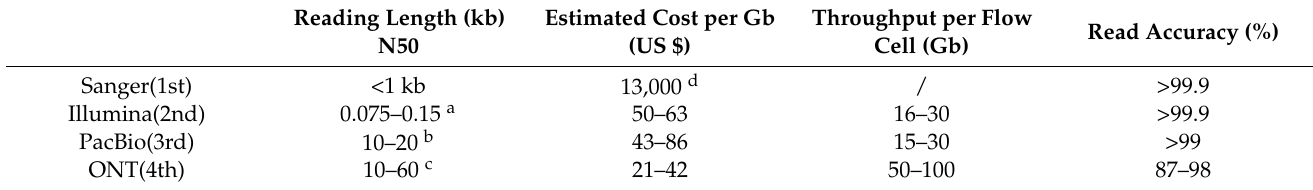
Table 1. The comparison of different generation of gene